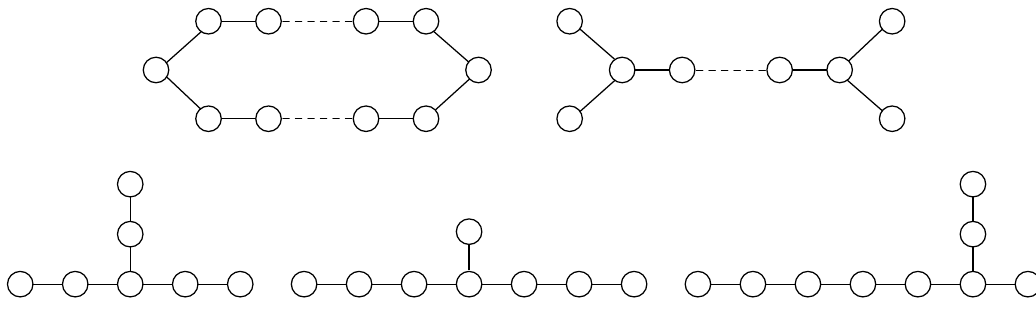
Figure 1 . A(cid:14)ne ADE quivers. From top to bottom and left to right b A n ; b D n ; b E 6 ; b E 7 ; b E 8